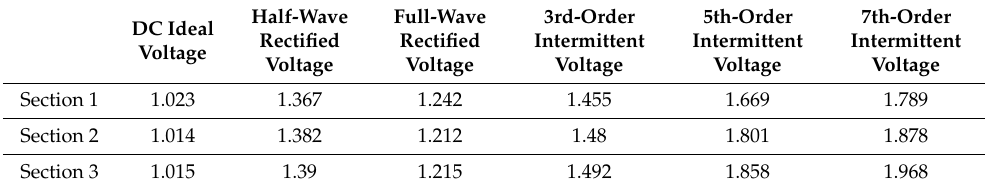
Figure 8. Current density-voltage characteristics at full-wave rectified voltage, without dust on the sections, with dust resistivity: ( a ). 10 11 Ω × cm; ( b ). 10 13 Ω × cm. Table 4. Form factor k 1 [-] of the supply voltage, sections free of dust.